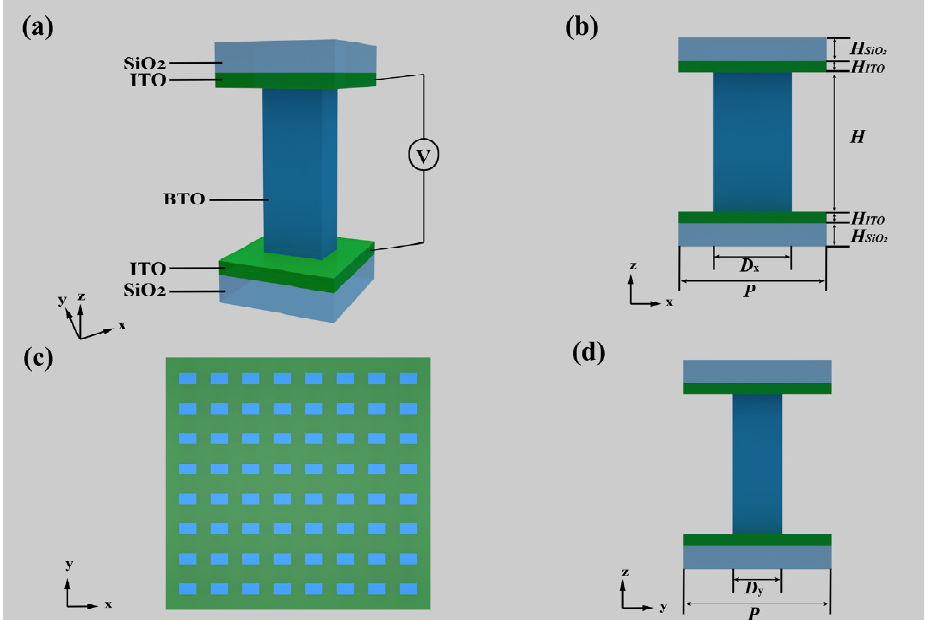
Figure 2. Schematic diagram of the meta-atom and its placement, in which ( a ) the perspective view, ( b ) front view and ( d ) left side view and ( c ) the placement are shown. The meta-atom of the depolarizer is composed of a BTO nanopillar, and two layers of ITO and SiO 2 substrates. The lattice constant of unit P is 350 nm; the heights of the SiO 2 , ITO and BTO materials, respectively, are H SiO2 = 200 nm, H ITO = 50 nm and H = 590 nm; and the length and width of the BTO nanopillars, respectively, are D x = 242 nm and D y = 100 nm. The voltage is applied to the BTO through two layers of ITO electrodes. ( c ) The meta-atom is placed with a rotation angle θ = 0 to make their simpler to